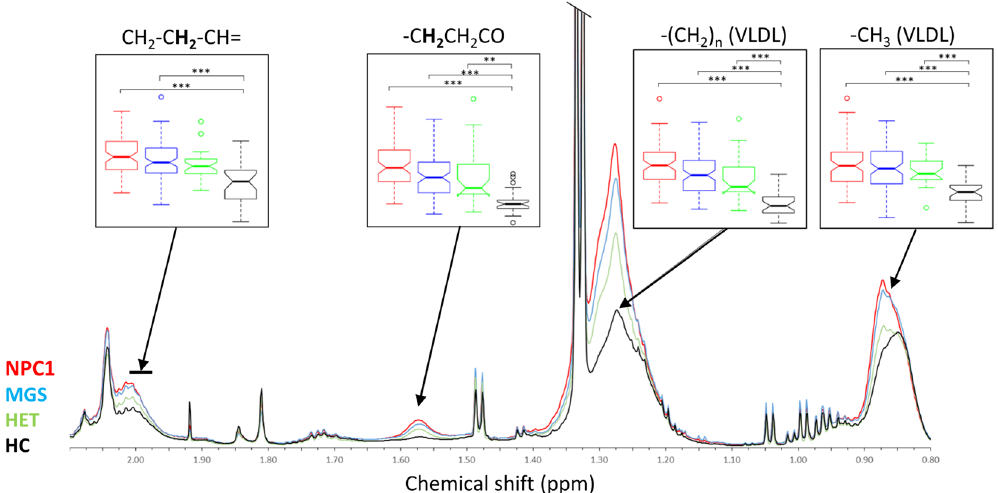
Figure 3. Lipid region (0.8–2.1 ppm) of average 1 H NMR spectra of NPC1 (red), MGS (blue), HET (green), and HC (black) plasma. Box plots illustrate the full range, interquartile range and median of the spectral integral of each region given (Bonferroni-corrected p-values < 0.05, 0.01, 0.001 are represented by * , ** and ***